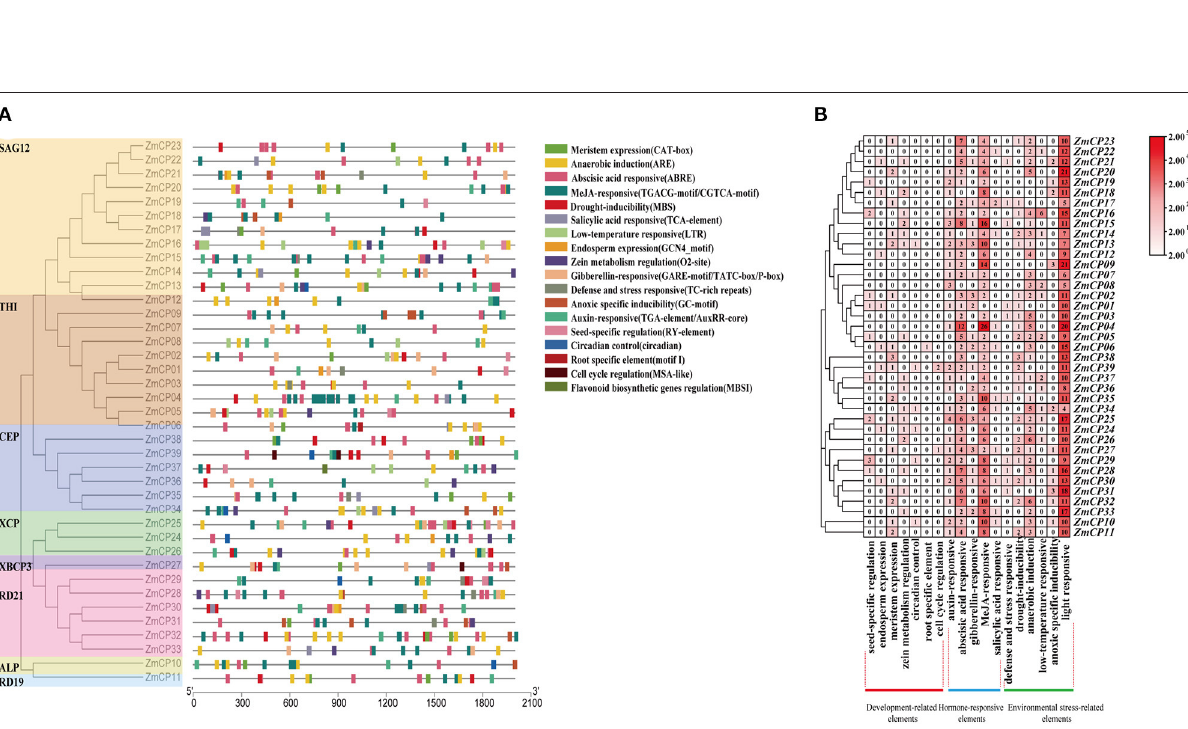
Frontiers in Plant Science |